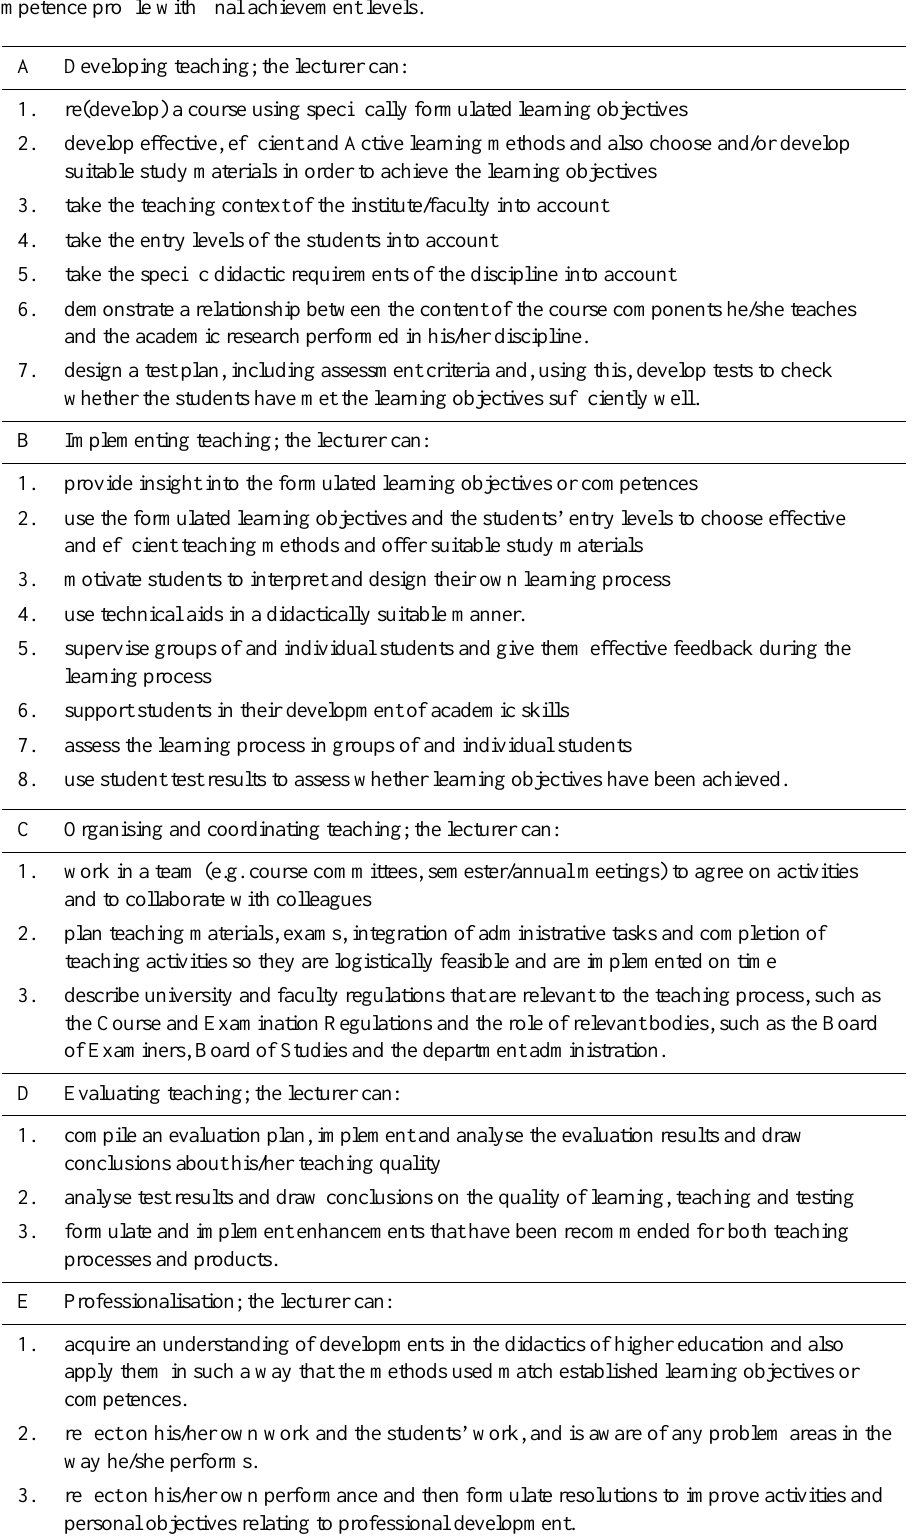
Table B1. UTQ Competence profile with final achievement